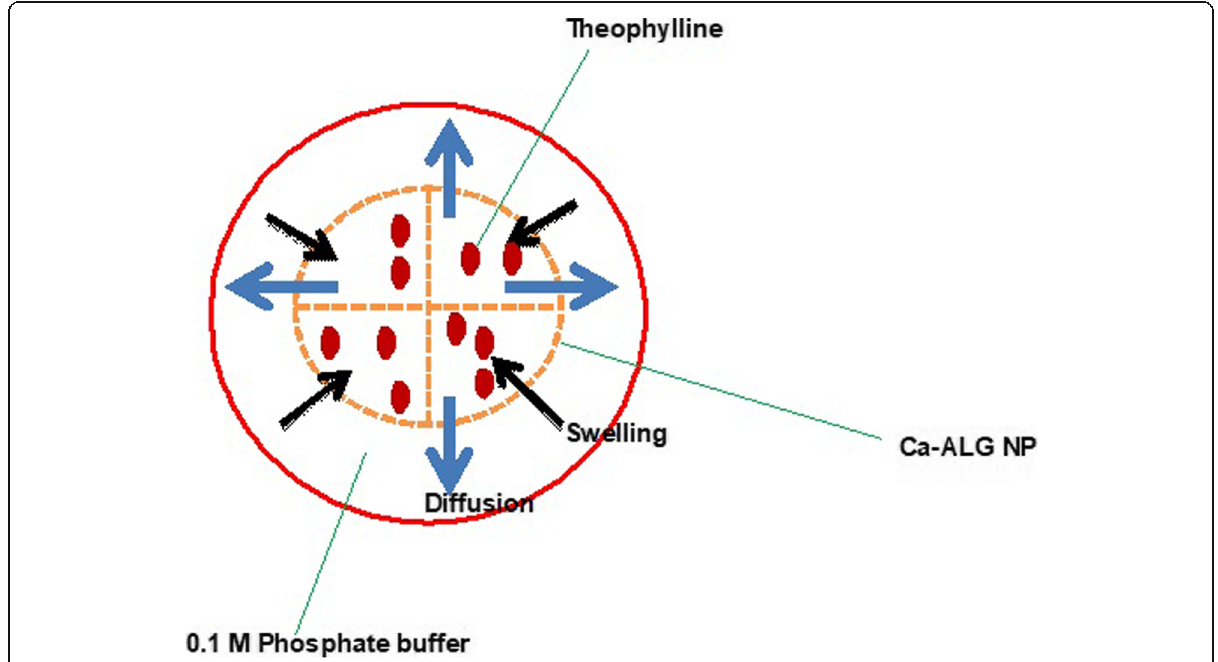
Fig. 1 Schematic of the drug-loaded spherical Ca-ALG NP